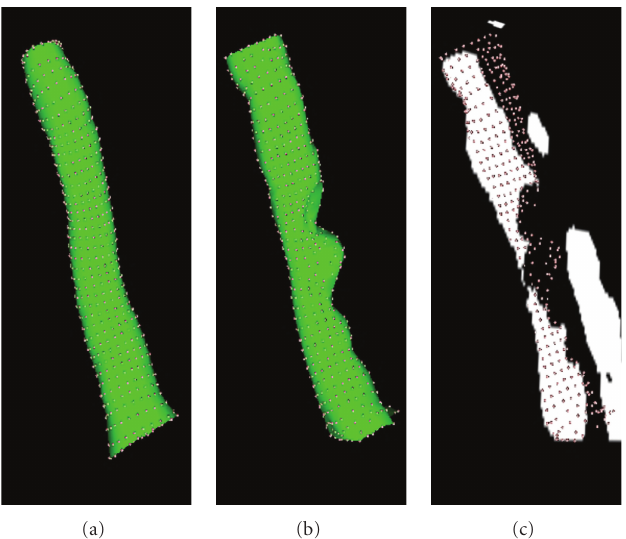
Figure 1: (a) The initial shape of the ACM (green) with the corresponding landmarks (red dots). (b) A step of the deformation algorithm. (c) The landmarks of the shape being deformed overlaid on an image of tracheal stenosis. Note the landmarks being attracted by the edges of the structures in the